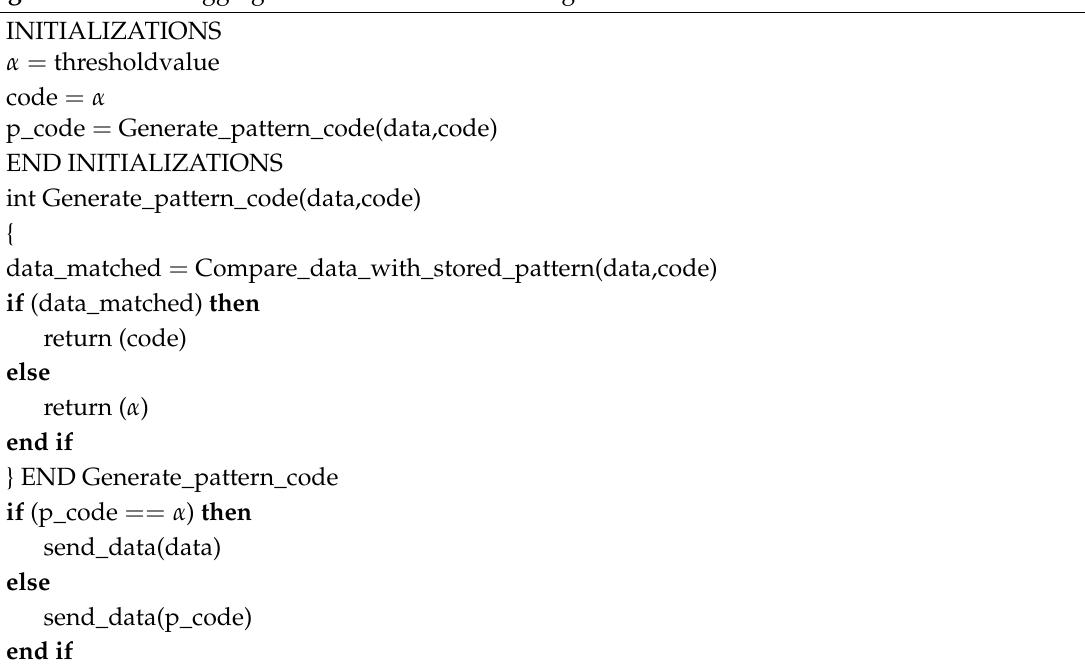
Algorithm 1 Data Aggregation with Pattern